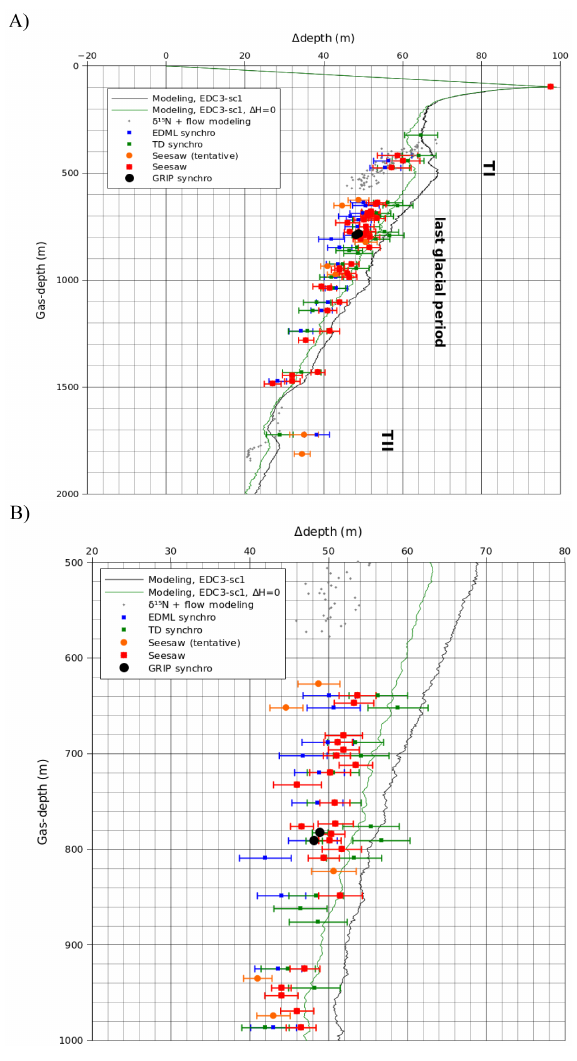
Fig. 8. 1 depth estimates along the EDC ice core. (A) Zoom on the 0–2000m depth interval, which shows the glacial and termination II 1 depth paradoxes. (B) Zoom on the 500–1000m depth interval en- compassing the Laschamp event. The error bars have to be taken as 1 σ uncertainty.